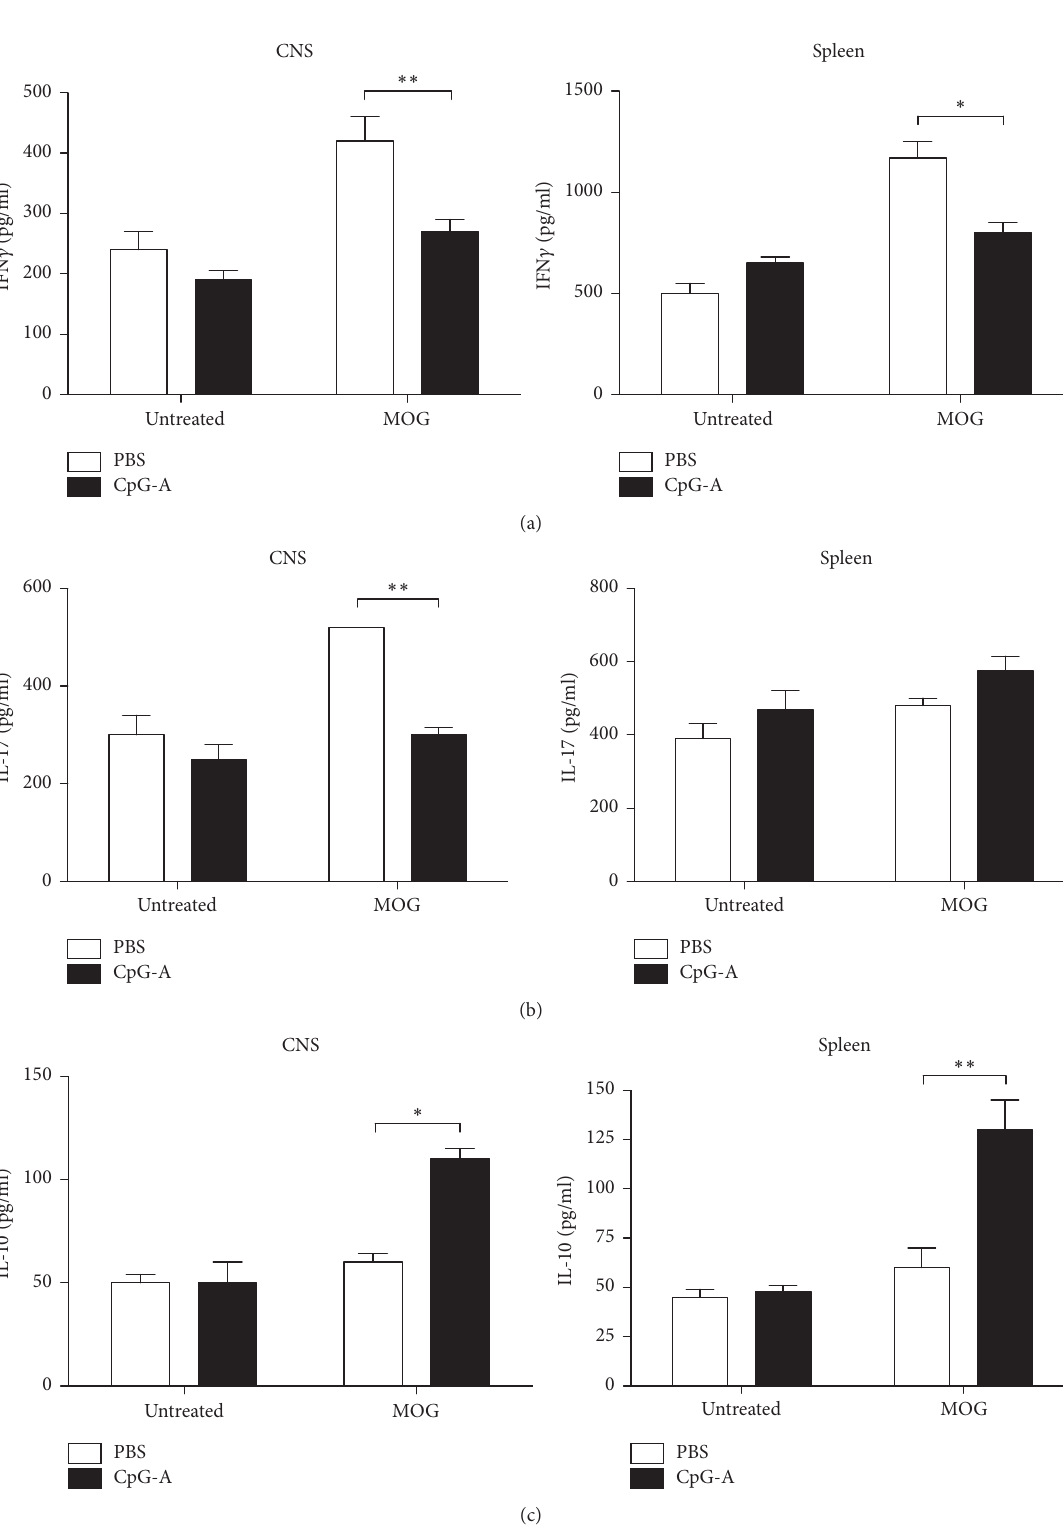
Figure 4: CpG-A treatment promotes regulatory cytokine responses. ELISA analysis of IFN- 𝛾 (a), IL-17 (b), and IL-10 (c) production from culture supernatants after MOG35–55 (25 𝜇 g/ml) stimulation of CNS-infiltrating cells or splenocytes from PBS- or CpG-A-treated mice at the peak of disease. Results shown are means ± sem from three independent EAE experiments. ∗ 𝑝 < 0.05 ; ∗∗ 𝑝 < 0.01 , two-tailed Mann–Whitney